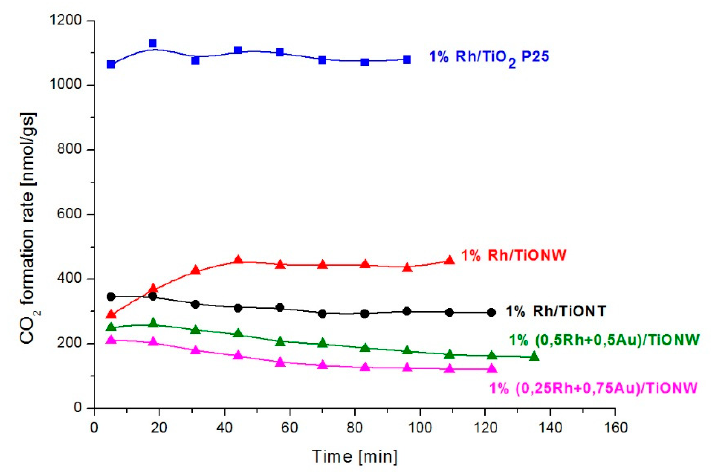
Figure 13. CO 2 formation rate in the CO + H 2 O reaction over di ff erent Rh catalysts at 550 K.